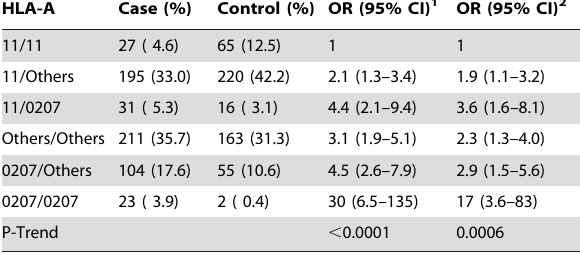
Table 2. Pooled Distribution, Odds Ratios and 95% Confidence Intervals for the Association Between Chromosome 6p21 HLA-A Alleles and